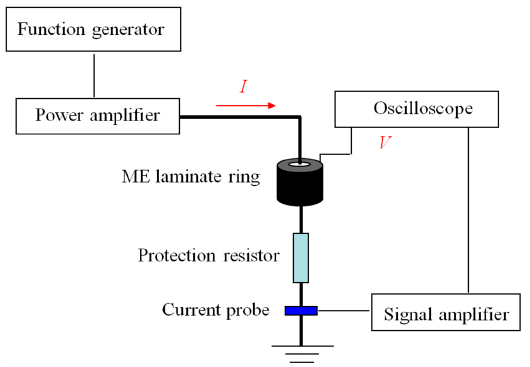
Figure 2. A schematic diagram of the experimental setup.